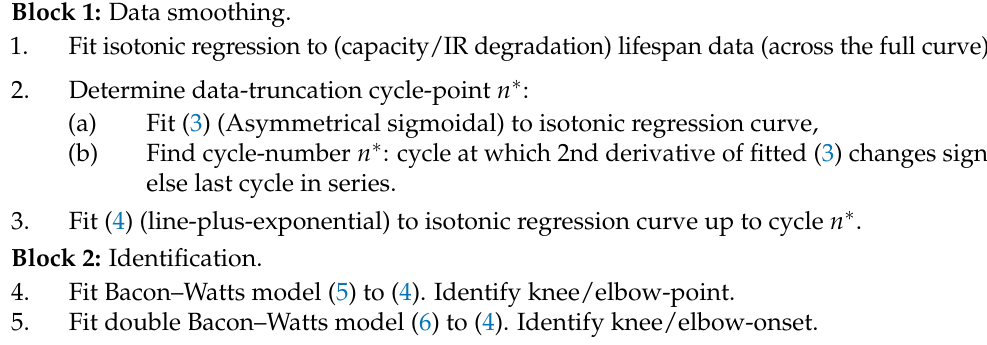
Algorithm 1 ’Smoothed Bacon–Watts’: Identification of knee/elbow-point and -onset Block 1: Data